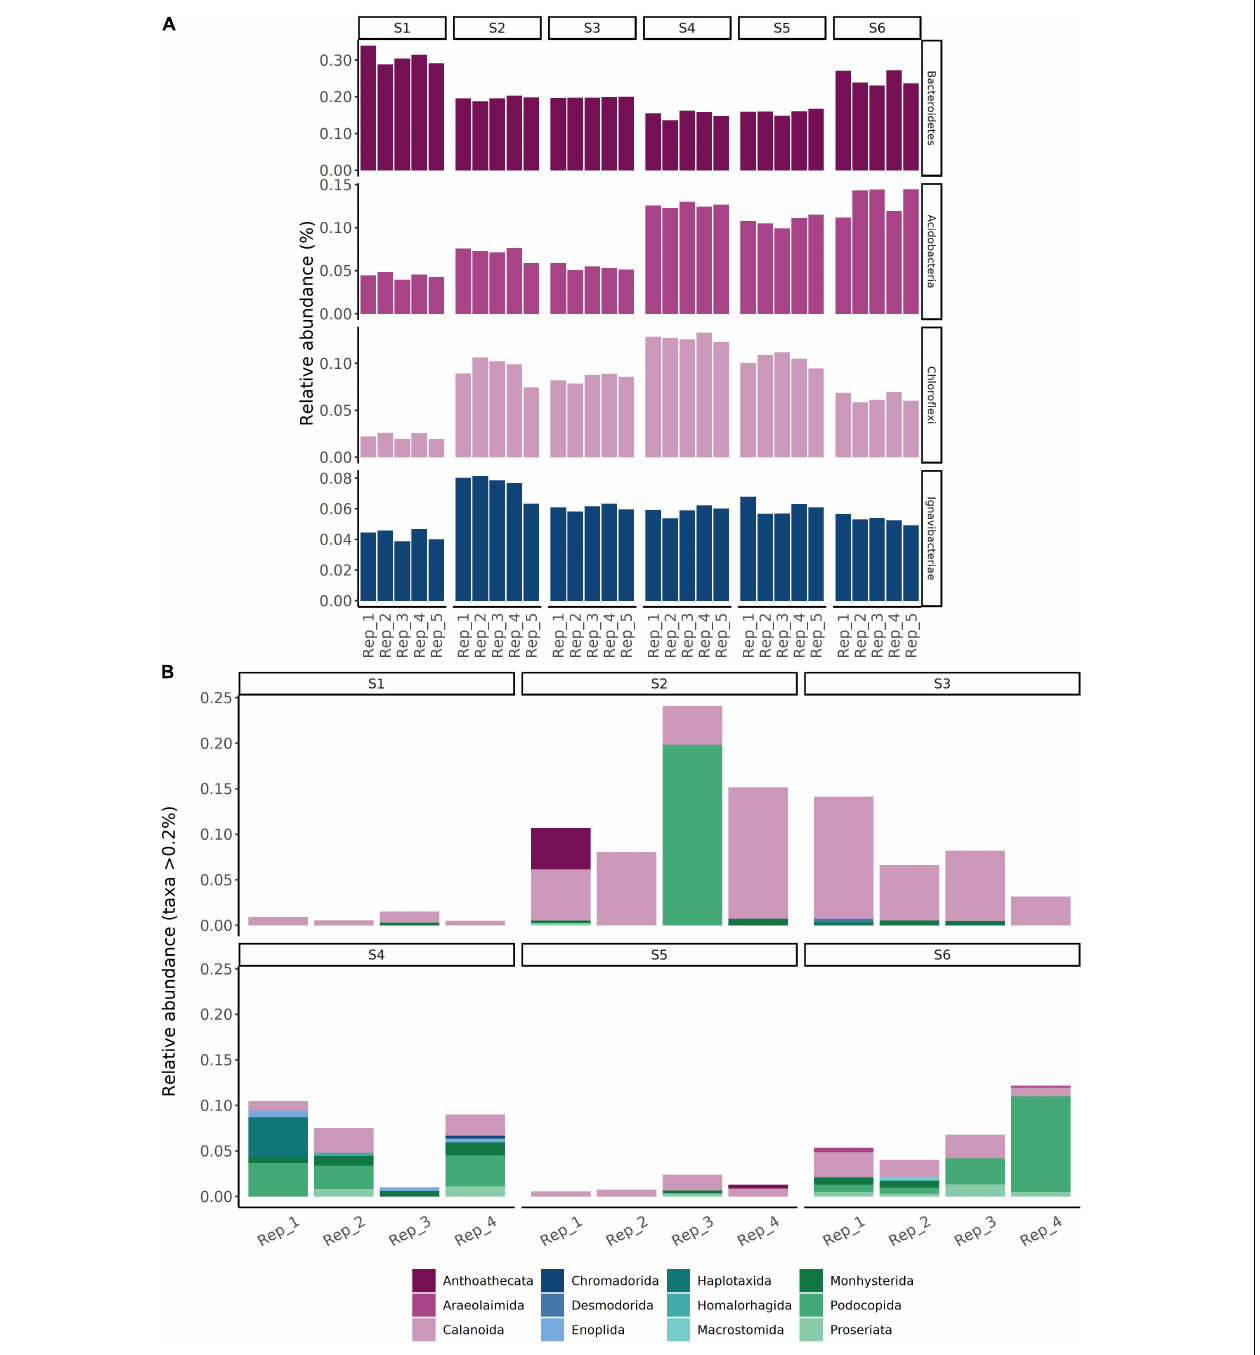
FIGURE 5 | Operational taxonomic unit relative abundances (%) corresponding to subsets of (A) bacterial and (B) eukaryotic communities within sediments collected from a total of six sampling sites in the Archipelago Sea (Baltic Sea, Finland). The bacterial community subset corresponds to the top four most abundant phyla, aside from members of the Proteobacteria . The eukaryotic community subset corresponds to metazoa.